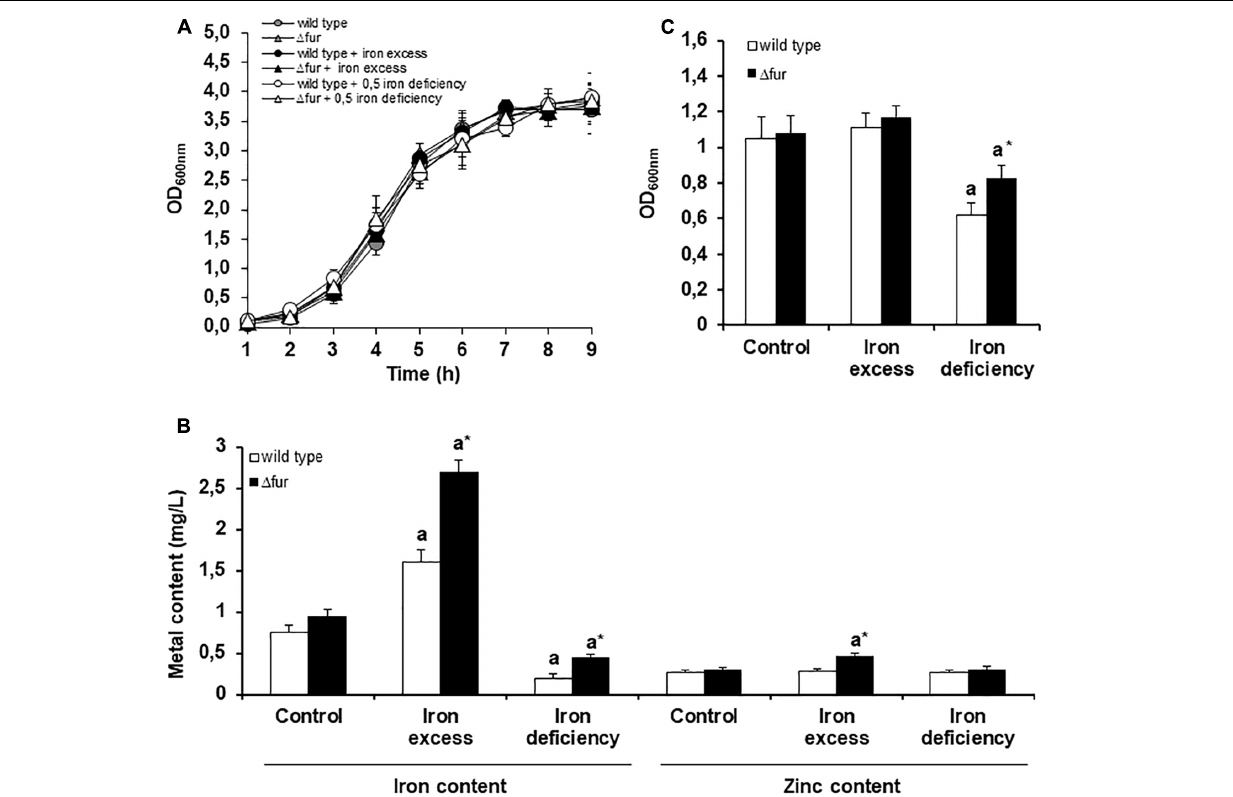
(TGAnAAnnnTTnTCA), was present in the set of 65